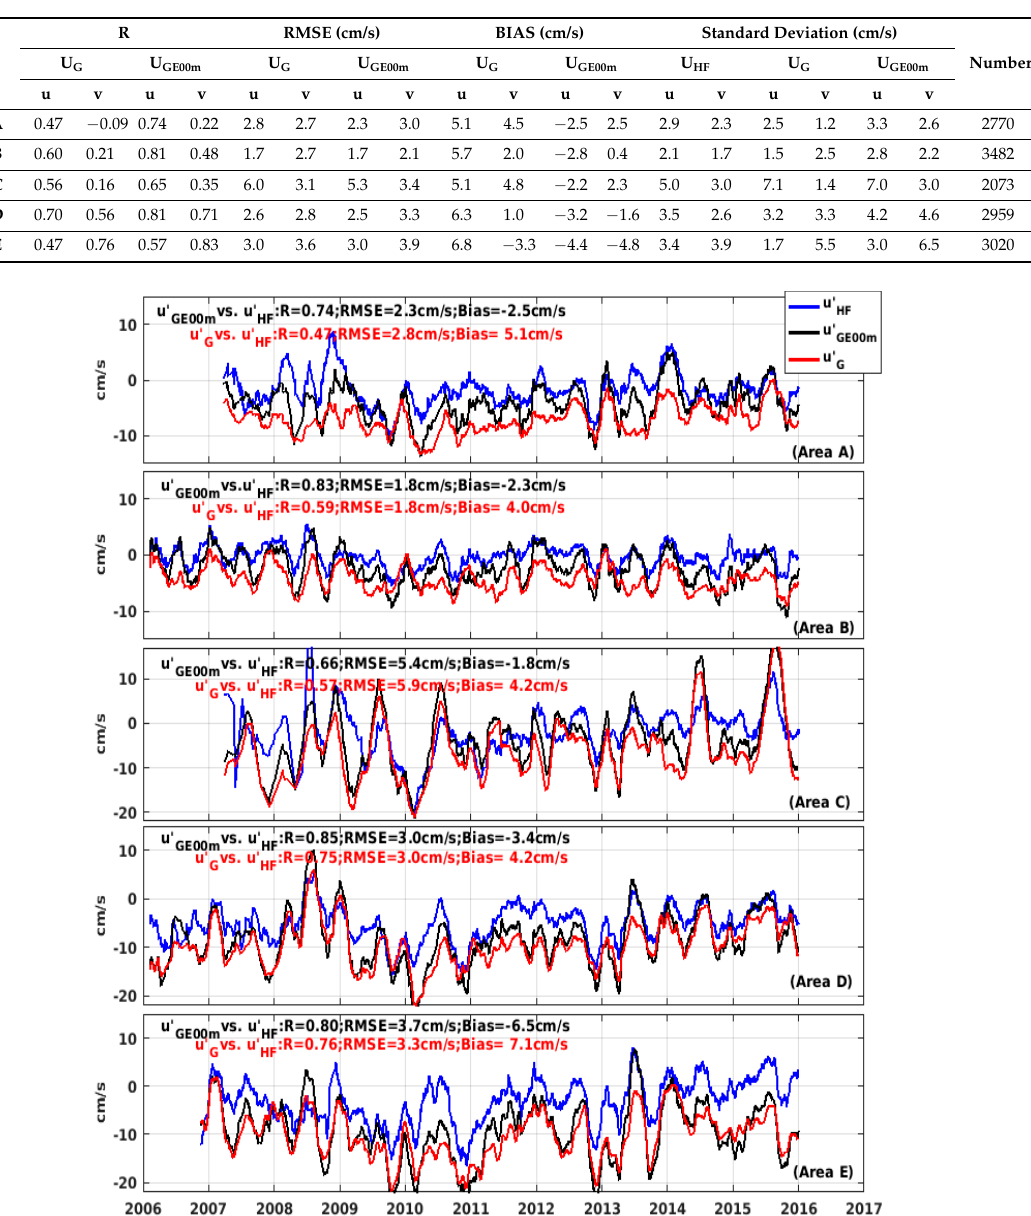
Figure 9. MAB low-passed (70-days running mean applied) time series of alongshelf current u’ component for in situ HF radar u’ HF (blue), GlobCurrent u’ GE00m (black) and u’ G (red) for the selected